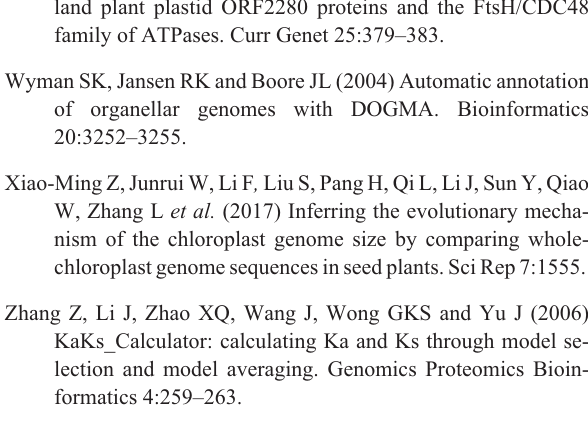
Figure S1 - Comparison of boundary positions between sin- gle copy and inverted repeat regions among 13 chloroplast genomes of Myrtales. Figure S2 - Bayesian phylogeny based on six most variable genes on chloroplast sequences of 48 Myrtaceae species and the outgroup Lagerstroemia fauriei (Myrtales: Lythraceae; KT358807). Figure S3 - Bayesian phylogeny based on five most variable genes on chloroplast sequences of 48 Myrtaceae species and the outgroup Lagerstroemia fauriei (Myrtales: Lythraceae;